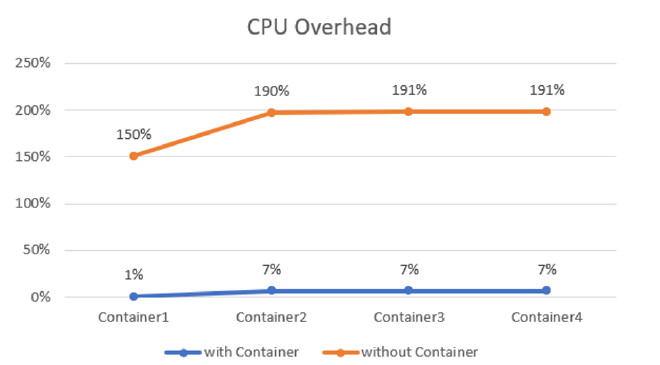
Figure 14. The graph representations of CPU overhead and CPU utilization with and without Docker.